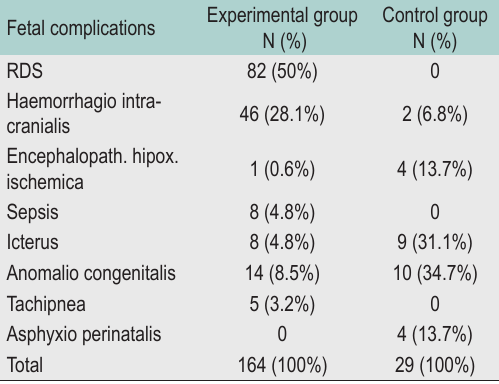
TABLE 3. The incidence of fetal complications in the experi- mental and control groups.